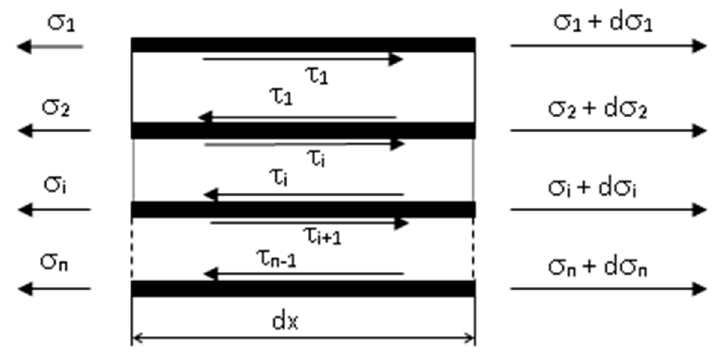
Figure 2. Stresses in an elementary length of a belt core cross-section, τ —shear stresses, σ —tensile stresses.